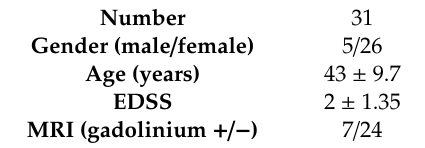
Table 1. Demographic and clinical characteristics of MS subjects at the time of